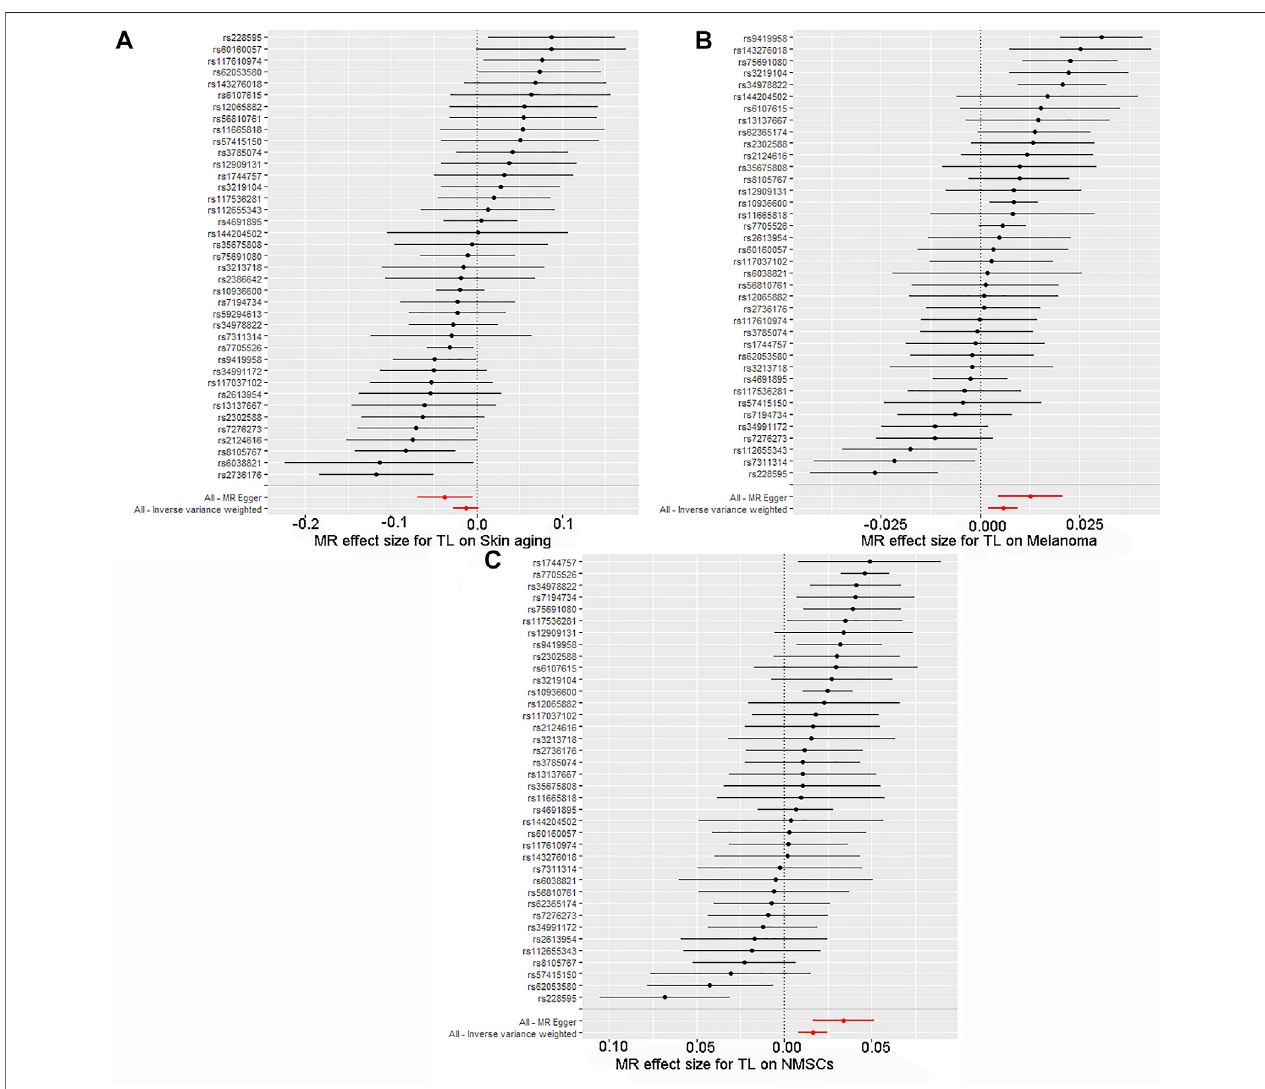
FIGURE4| ForestmapofskincancerandagingriskbasedonTLgeneticvariants. (A) Skinaging; (B) Melanoma; (C) NMSCs.SNPsofTLwereanalyzedusingIVW and MR-Egger. Black dots represent estimates of causal effects of TL on skin cancer and aging (beta coef fi cients). The black line represents the estimated 95% con fi dence interval.